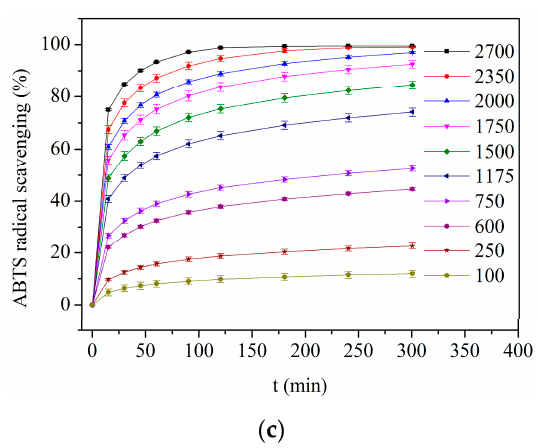
Figure 4. Antioxidant activity of AVE solutions at different concentration levels with time by ( a ) DPPH ( b ) FRAP and ( c ) ABTS assays. AVE concentration levels are expressed in mg AVE kg − 1 .